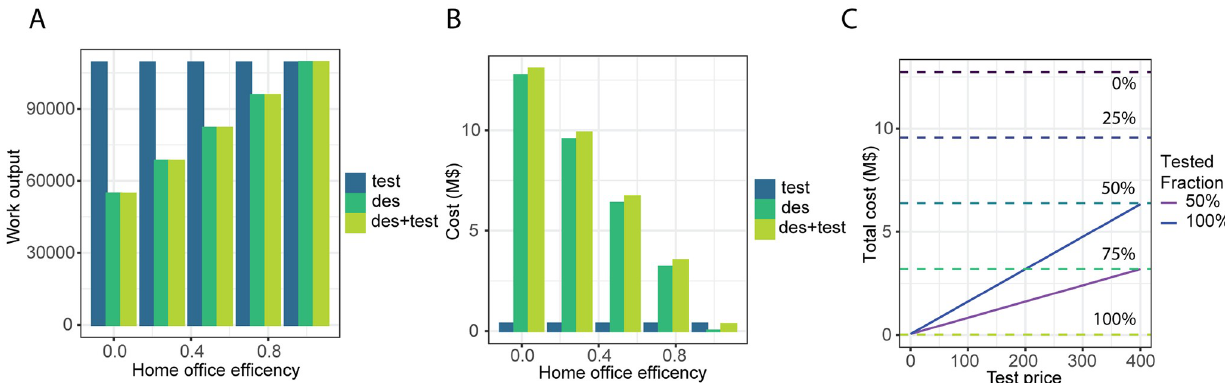
Fig 4. Economical impact. (A) Work output at the end of the simulation as a function of the home office efficiency for the different strategies. (B) Total cost of the measures as a function of the home office efficiency for the different strategies. (C) Total cost of the measures as a function of the cost per test. horizontal lines represent the cost of desynchronization for different levels of home-office productivity. Average of 1000 Gillespie simulations for (A, B, C). test: testing strategy; des: desynchronization strategy; des+test: combining testing and desynchronization strategy.